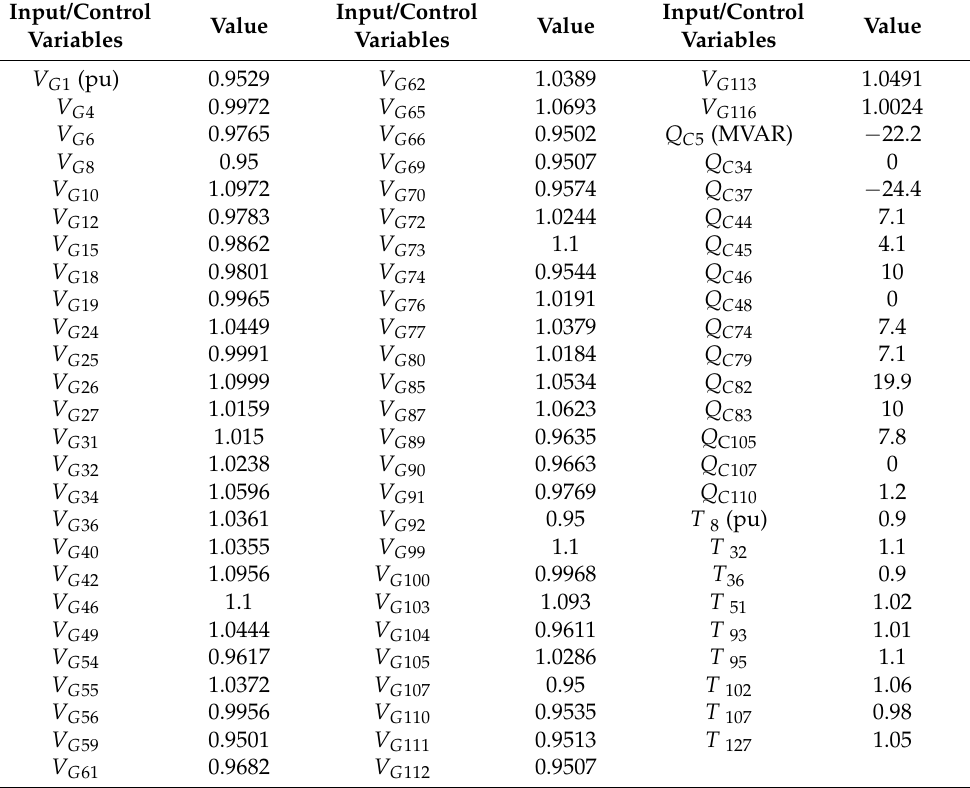
Table A8. Optimal solution obtained by ICOA for L index objective of the IEEE 118-bus power system with the case of discrete